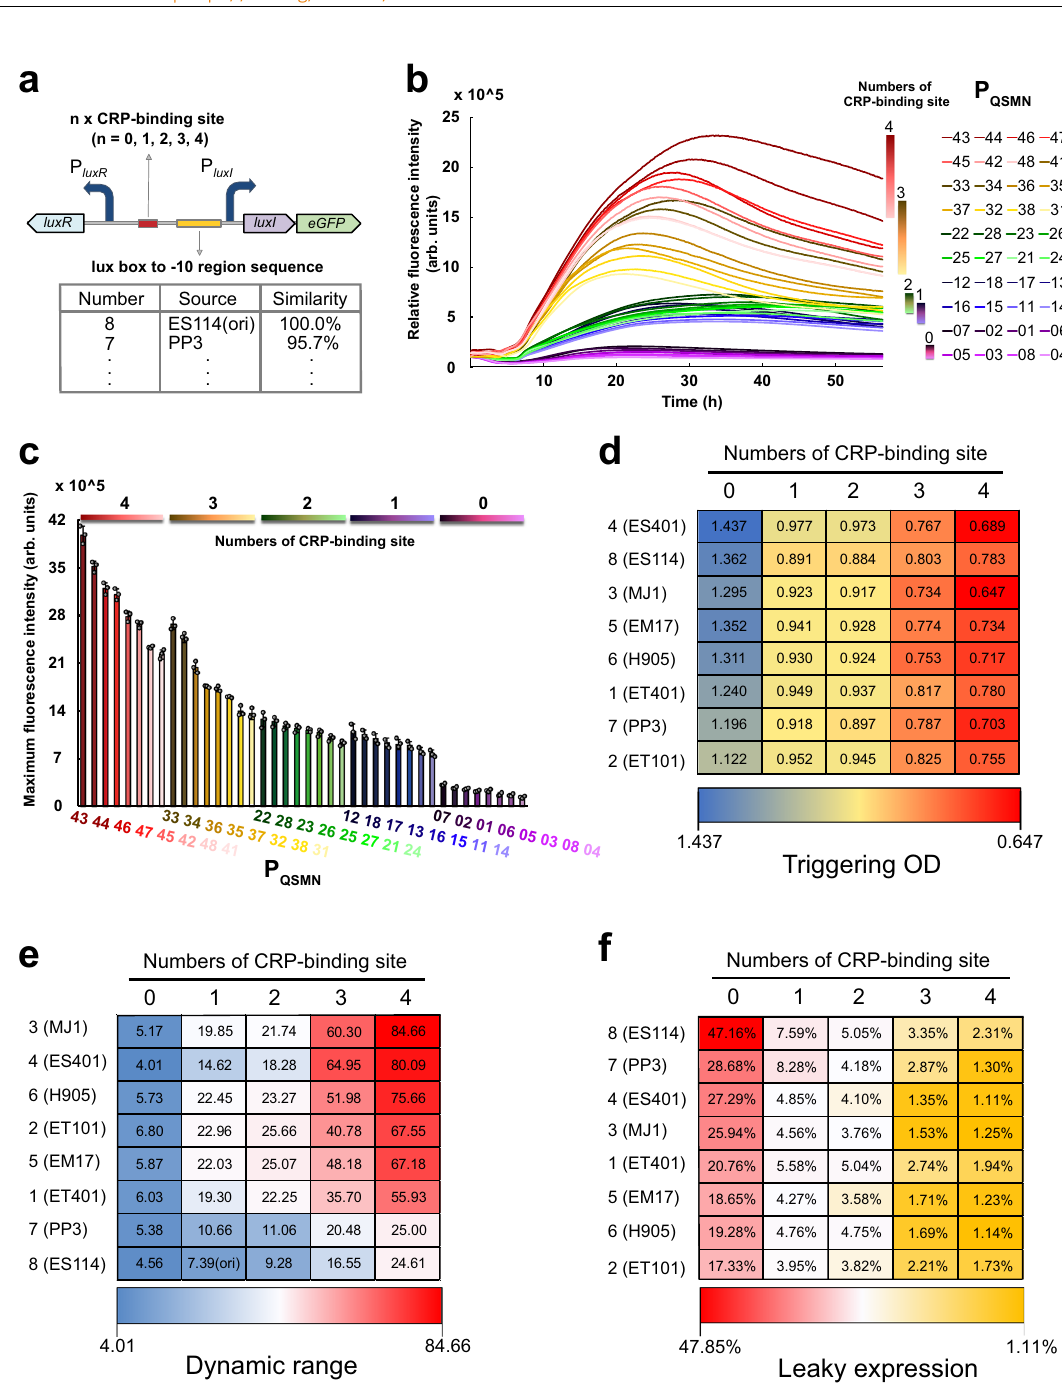
Fig. 2 Establishment and characterization of QS variant library. a Architecture of the QS variant in the library. b Gene expression dynamics of each QS variant in the library. Each QS variant was named P QSMN , “ M ” represents the copy number of the CRP-binding site carried by the QS variant. “ N ” represents the source of the “ lux box ” to “ − 10 ” site sequence contained by the QS variant. c The peak fl uorescence intensity of each QS variant in the library. d Triggering OD for each QS variant in the library. e Dynamic range for each QS variant. f Leaky expression for each QS variant. The leaky expression was exhibited as the ratio of comparing peak fl uorescence intensity from strains carrying partial QS circuits in the absence of luxR and luxI to that of strains harboring entire QS circuits in the presence of luxR and luxI . Data shown are mean ± SD ( n = 3 independent experiments). Source data are provided as a Source Data fi